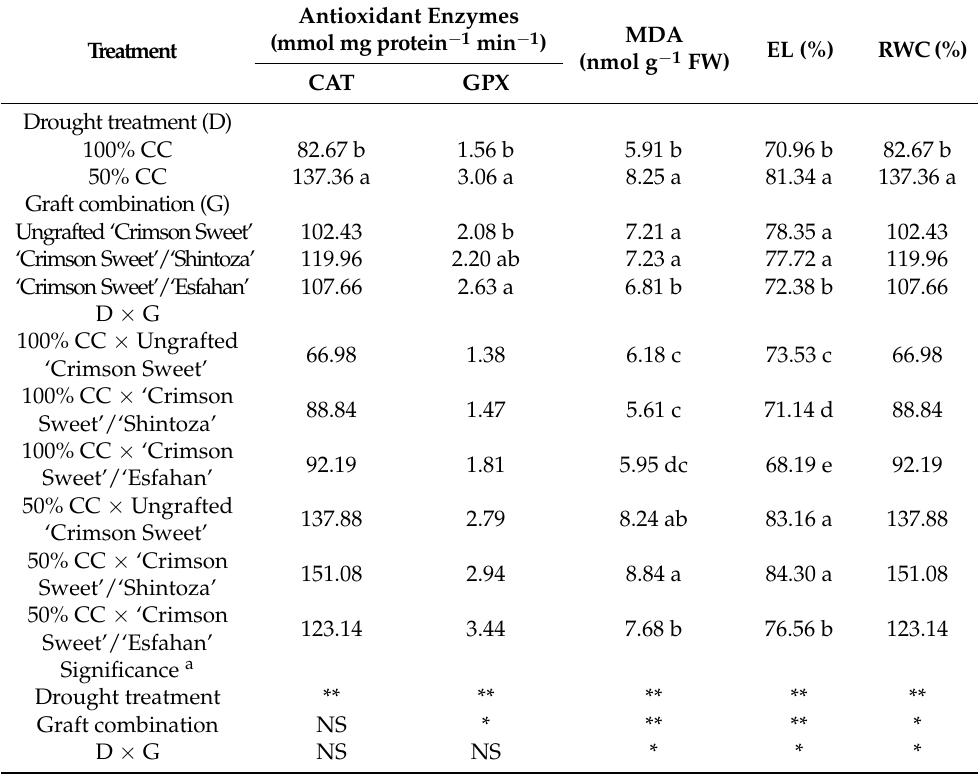
Table 3. Effects of grafting combination and drought treatment on catalase (CAT), and guaiacol peroxidase (GPX) activities, malondialdehyde content (MDA), electrolyte leakage (EL) and leaf relative water content (RWC) of watermelon plants. Antioxidant Treatment